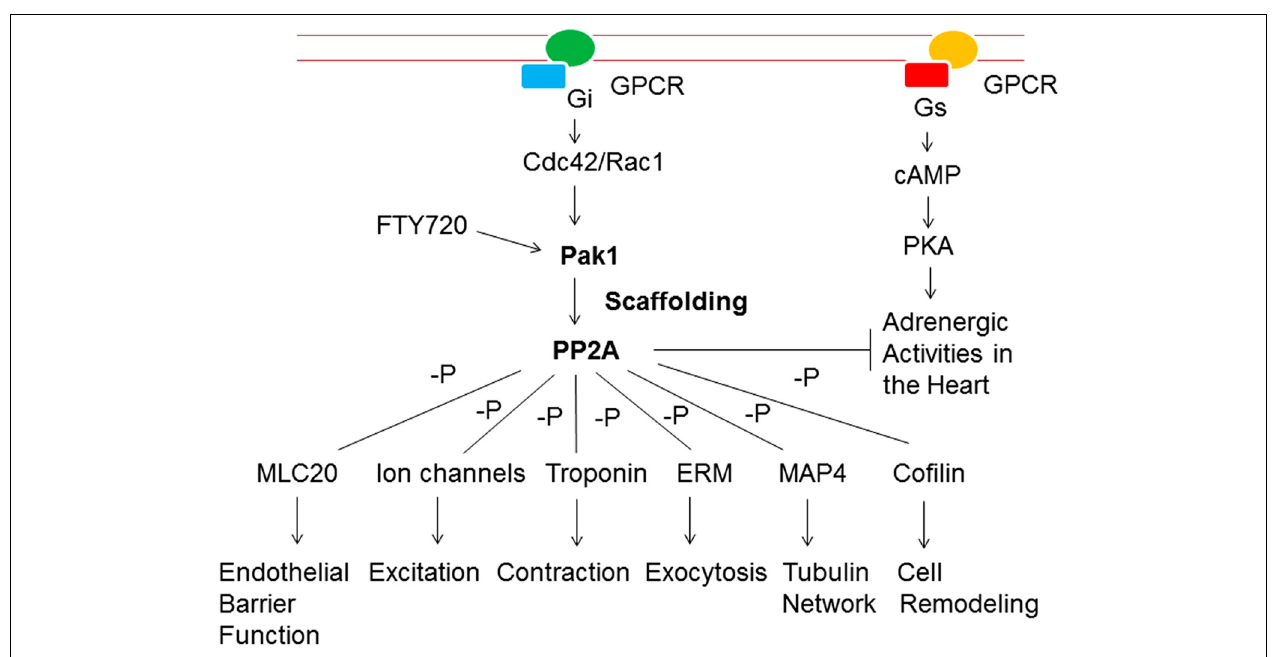
FIGURE 4 | Scaffolding of Pak1-PP2A induces different functional changes in endothelial, cardiac and other mammalian cells. It is also a novel anti-adrenergic mechanism in the heart.The Pak1-PP2A scaffolding can be enhanced by small molecular weight compounds such as FTY720. See text for further